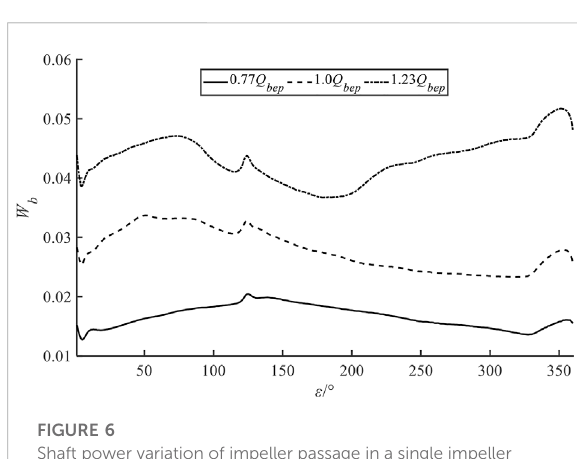
FIGURE 6 Shaft power variation of impeller passage in a single impeller